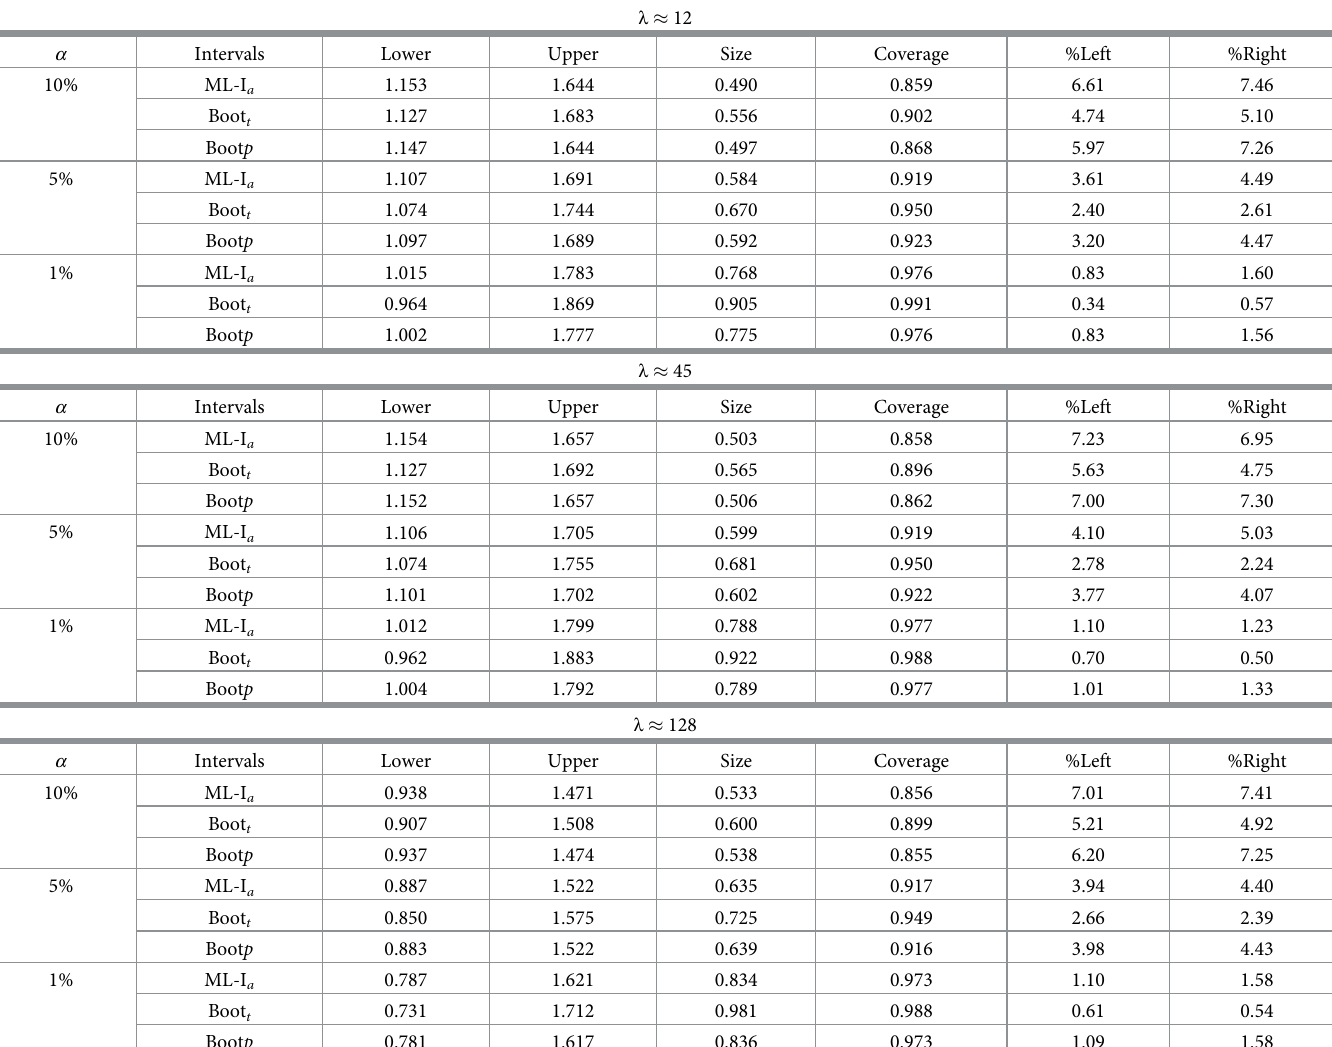
= 1 (cid:0) μ Þ ¼ β þ x β 2 þ β þ β and log ð σ 2 Þ ¼ γ þ z γ 2 , t = 1, ... , n , μ t 2 (0.02, 0.32), β 2 = 1.2, n = x x t t 2 t t 1 3 t 3 4 t 4 1 t